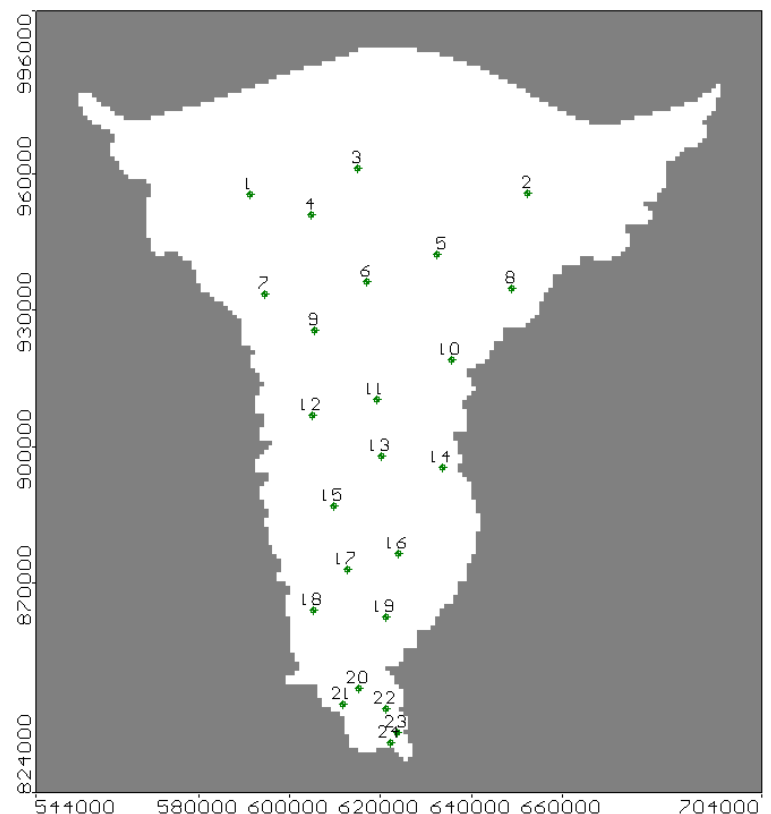
Figure 5. The distribution of observation wells in the MNDA.